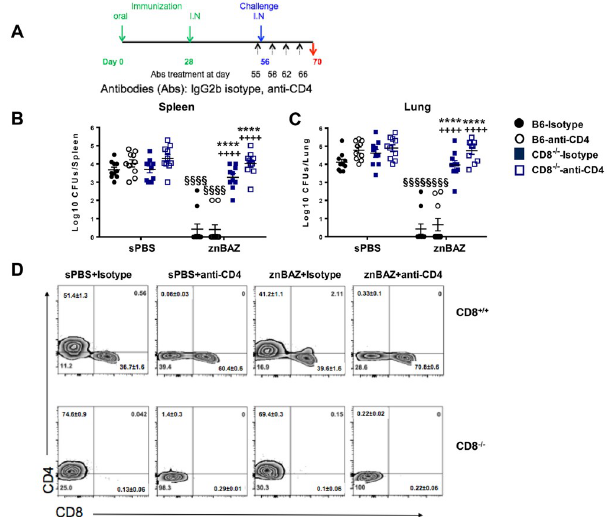
Fig 9. Superior protective efficacy conferred by lung CD8 + T RM cells following mucosal znBAZ vaccination. (A) C57BL/6 (B6) and C57BL/6 CD8 -/- (CD8 -/- ) mice were orally primed and nasally boosted with sPBS and znBAZ as depicted. On day 56, all mice were challenged with B . abortus 2308, and on days 55, 57, 62, and day 66, mice were treated IP with isotype control or anti-CD4 mAb. On day 70, all mice were assessed for extent of colonization by wt B . abortus 2308 in (B) lungs and (C) spleens. (D) Flow cytometry analysis of CD4 + and CD8 + expression from TCR- β + cells in the lungs post-challenge following isotype or anti-CD4 mAb treatment for each vaccination group in B6 and CD8 -/- mice was assessed (n = 10 mice per group). The data depict the mean ± SEM of two independent experiments; the differences were determined when compared to isotype control-dosed B6 mice ( ���� P < 0.0001), or compared to anti-CD4 mAb-treated B6 mice ( ++++ P < 0.0001). The difference between sPBS and znBAZ immunization groups are indicated ( §§§§ P < 0.0001). Analysis of variance with Two-way ANOVA Tukey’s multiple comparisons test was